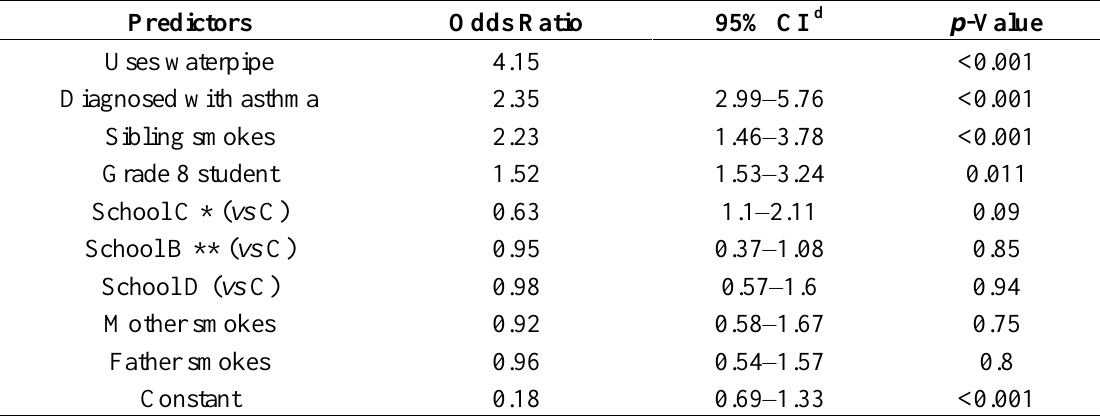
Table 4. Predictors of students ever having smoked cigarettes.